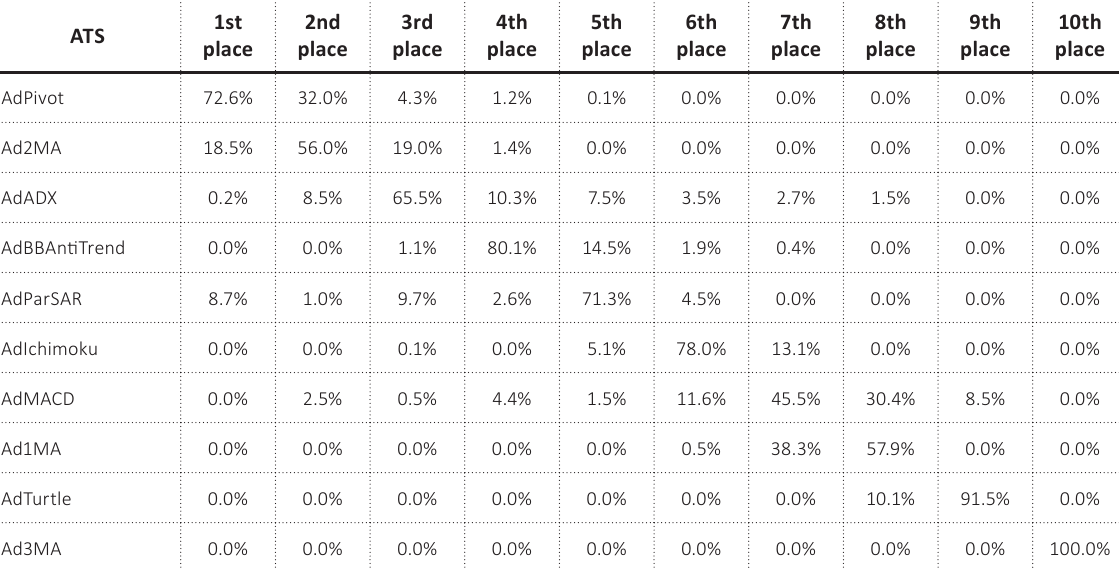
Table 2. Classification occurrences for all systems based on the WM values for best BTs ATS